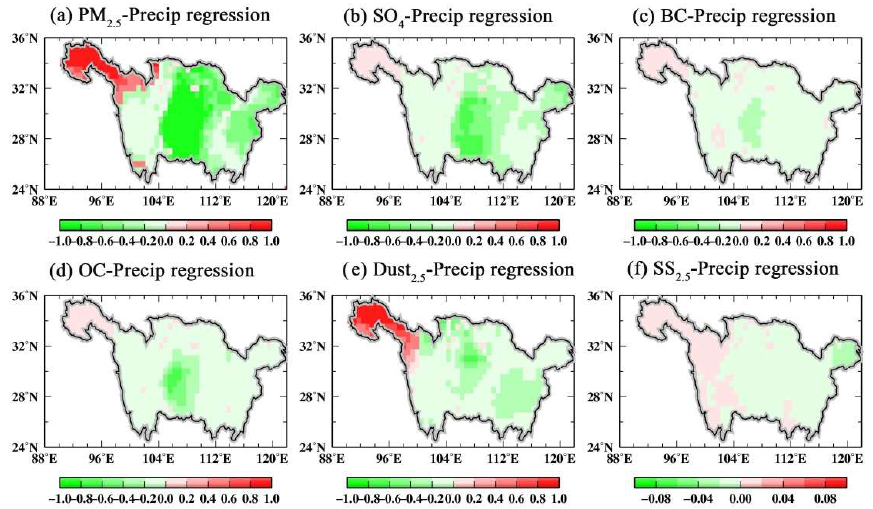
Figure 14. Multiple linear regression coefficients ( β 3 ) of each PM 2.5 component with surface precipitation (Precip), in units of µ g m − 3 mm − 1 day. ( a – f ) refer to the regression coefficients of PM 2.5 , SO 4 , BC, OC, Dust 2.5 and SS 2.5 with precipitation,